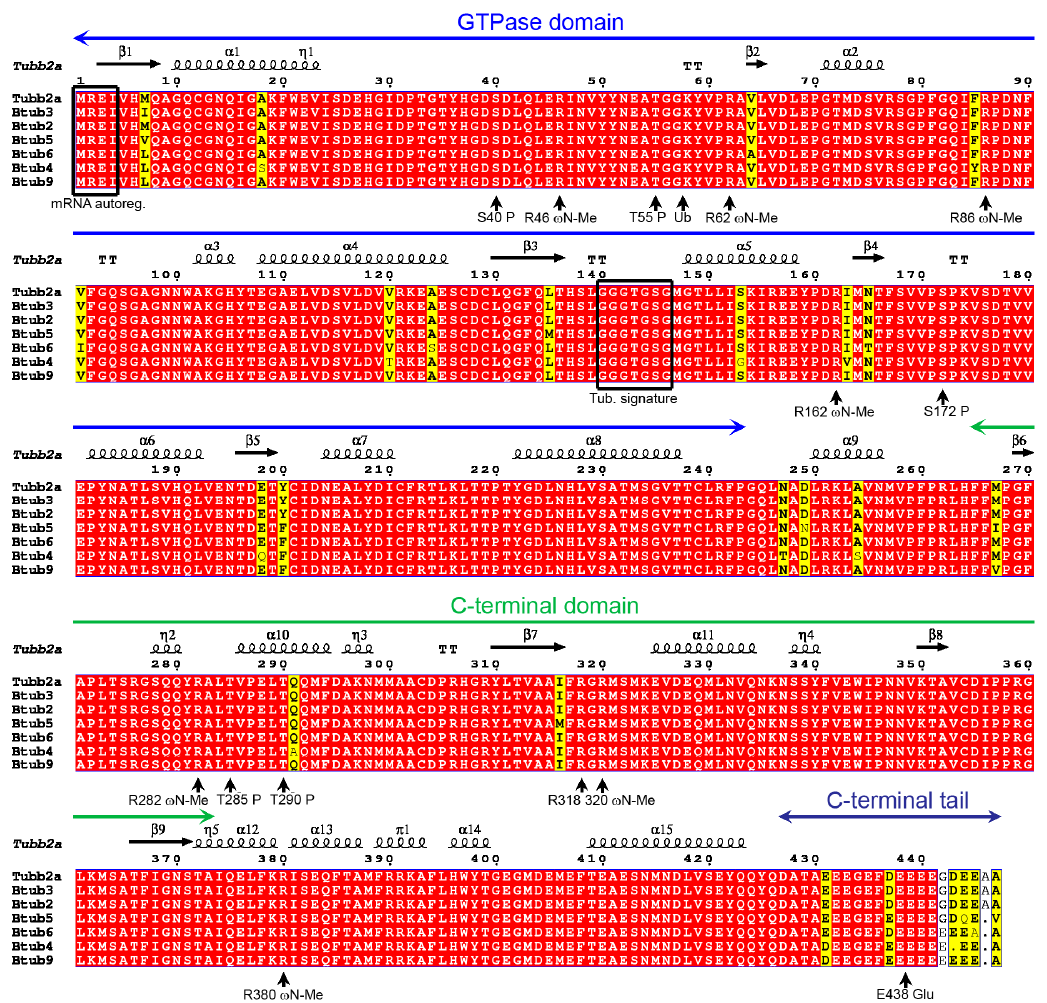
Figure 2. MSA of the β -tubulins of P. lividus . Alignment was performed with T-coffee and rendered by ESPript 3.0. Similar residues are written in black bold characters and boxed in yellow whereas conserved residues are in white bold characters and boxed in red. The sequence numbering on the top refers to the alignment. Tubulin domains are highlighted by long arrows also on the top. The principals PTMs are indicated on the bottom. Me: methylation; P: phosphorylation; Glu: polyglutamylation and polyglycylation.